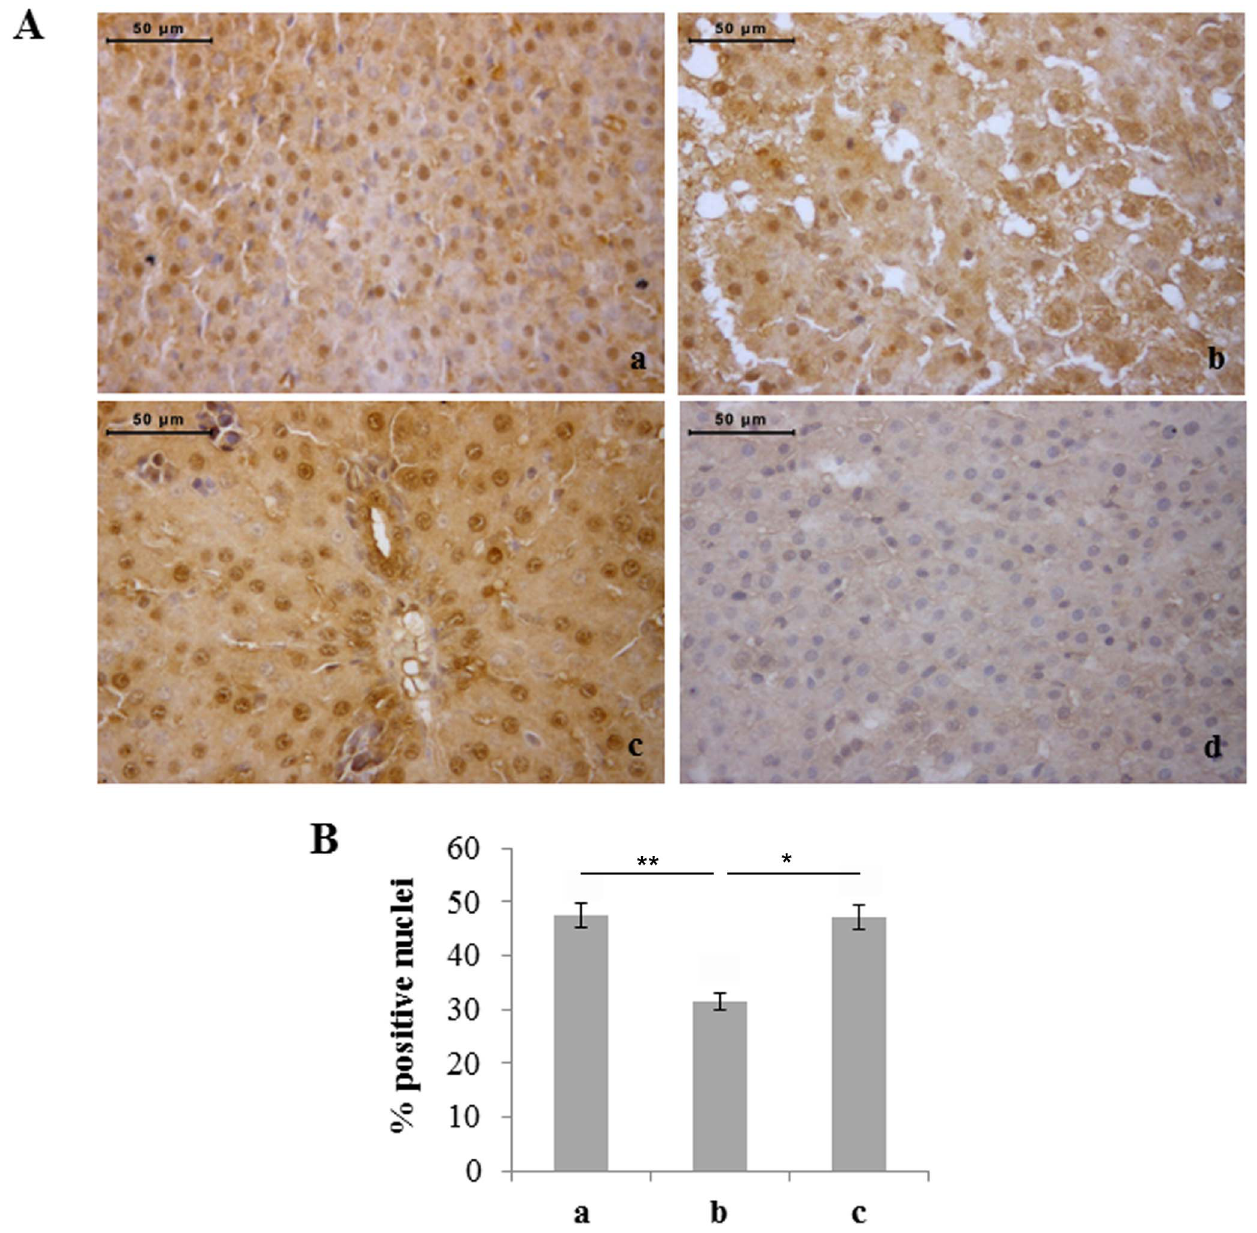
Figure 10. Moderate hyperoxia reduces the number of NF-kB positive hepatocytes with respect to normoxia and severe hyperoxia. A) Immunohistochemical detection of Nf k b expression in neonatal rat livers exposed to moderate and severe hyperoxia. a) ambient air; b) 60% hyperoxia; c) 95% hyperoxia; d) negative control; scale bar: 50 m m, magnification 40x. B) Graphic representation of the percentages of NF-kB positive nuclei ( 6 SD); densitometric analysis determined by direct visual counting of ten fields for each of three slides per sample. *=p , 0.05; **=p ,